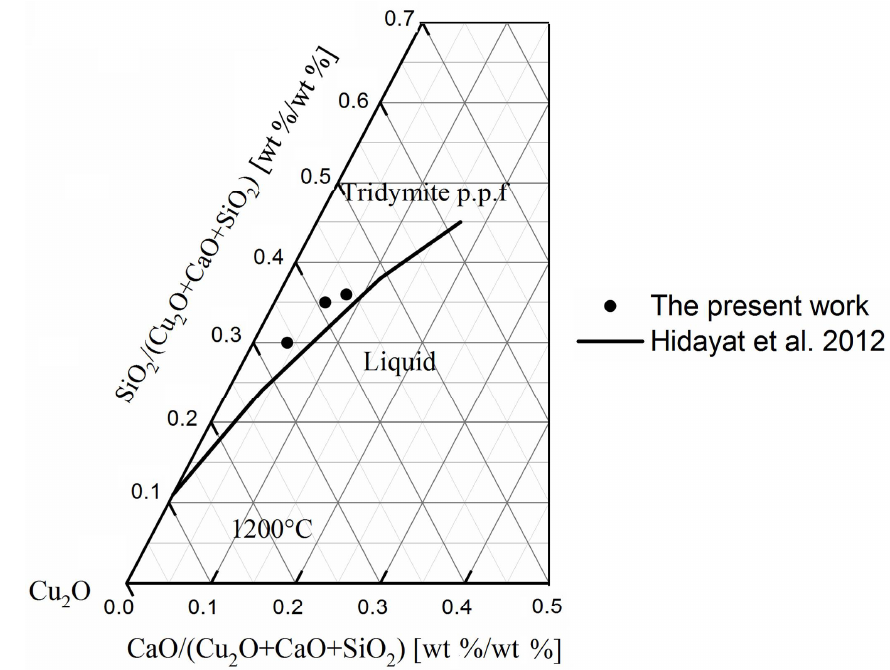
Figure 9. Liquidus lines of the Cu 2 O–CaO–SiO 2 system in equilibrium with tridymite and metallic copper at 1200 ◦ C.